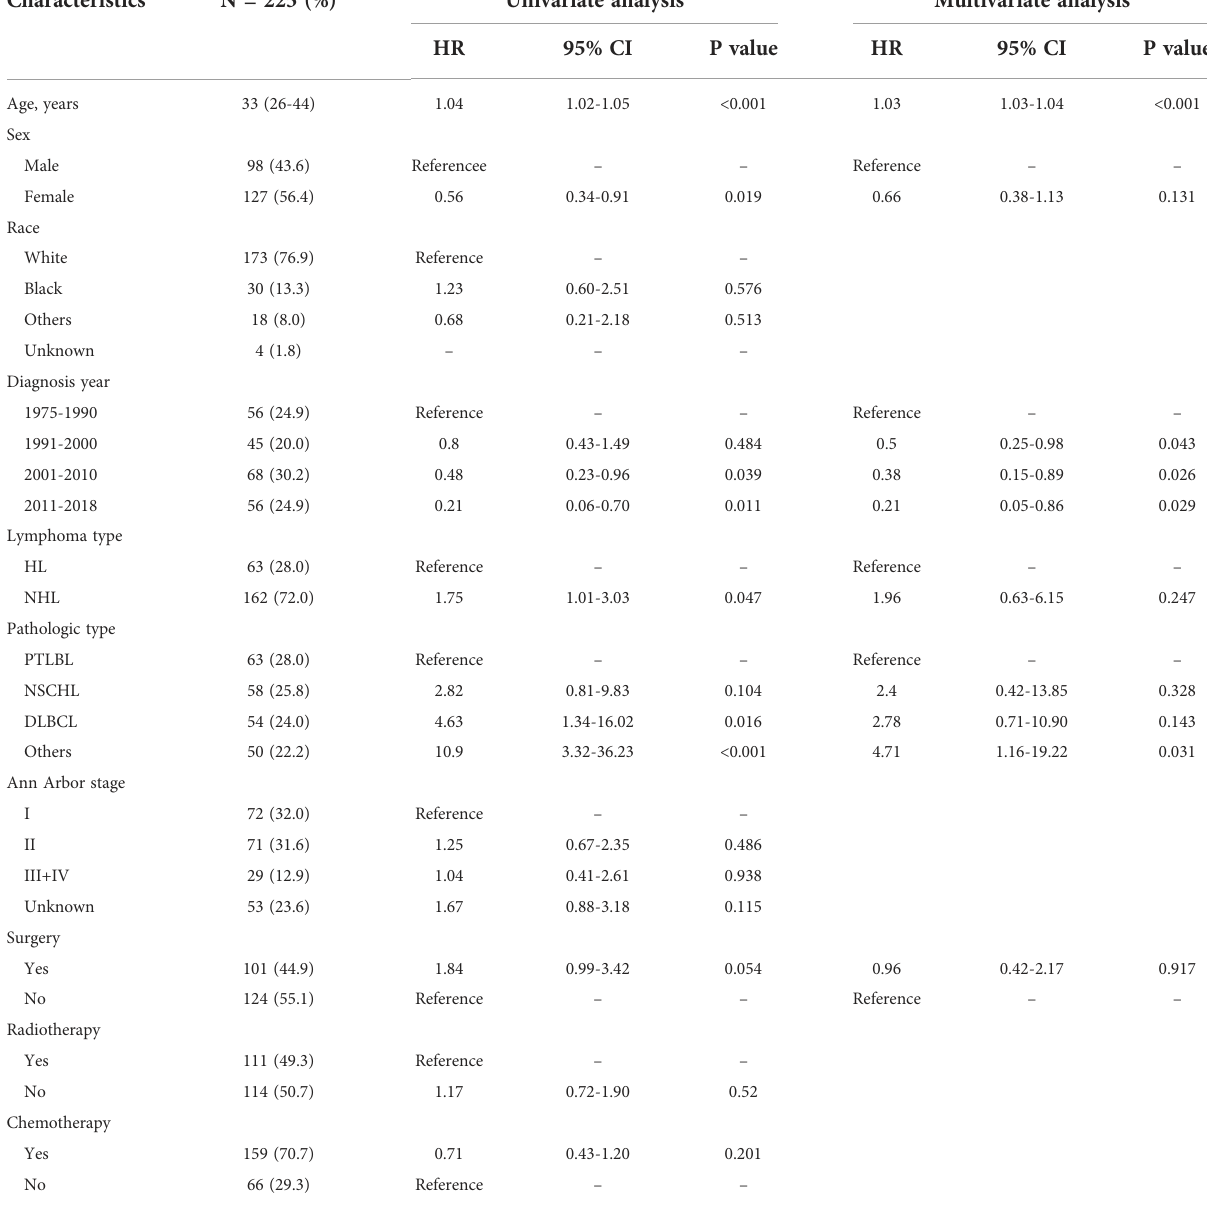
TABLE 1 Univariate Cox regression analyses for overall survival in 225 patients with thymic